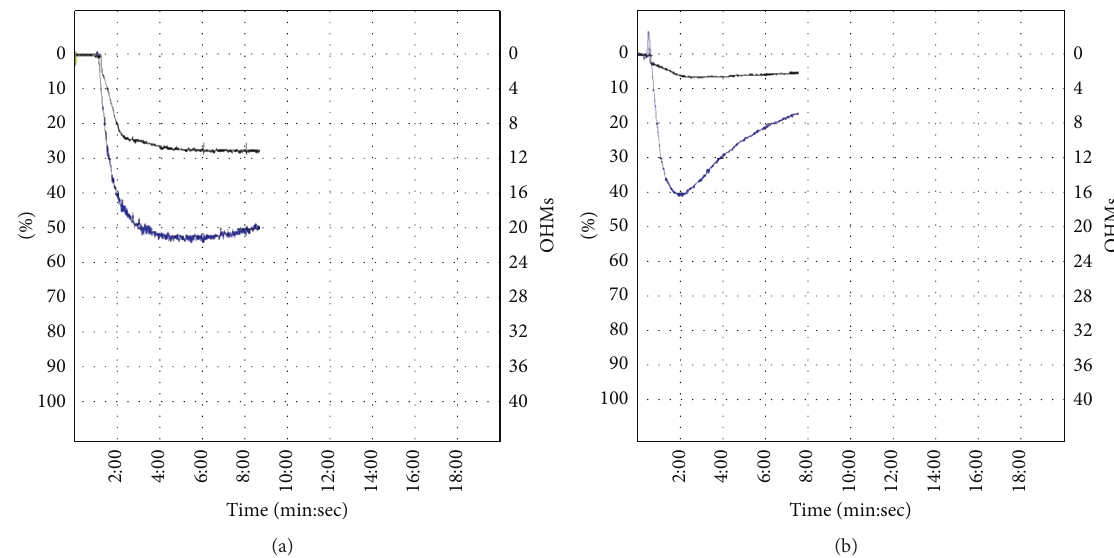
Figure 1: LTA with specific inducers (arachidonic acid: black curve, adenosine diphosphate: blue curve) showing difference between HTPR (a) and sufficient antiplatelet response (b) in T2D patient with acute ST-elevation myocardial